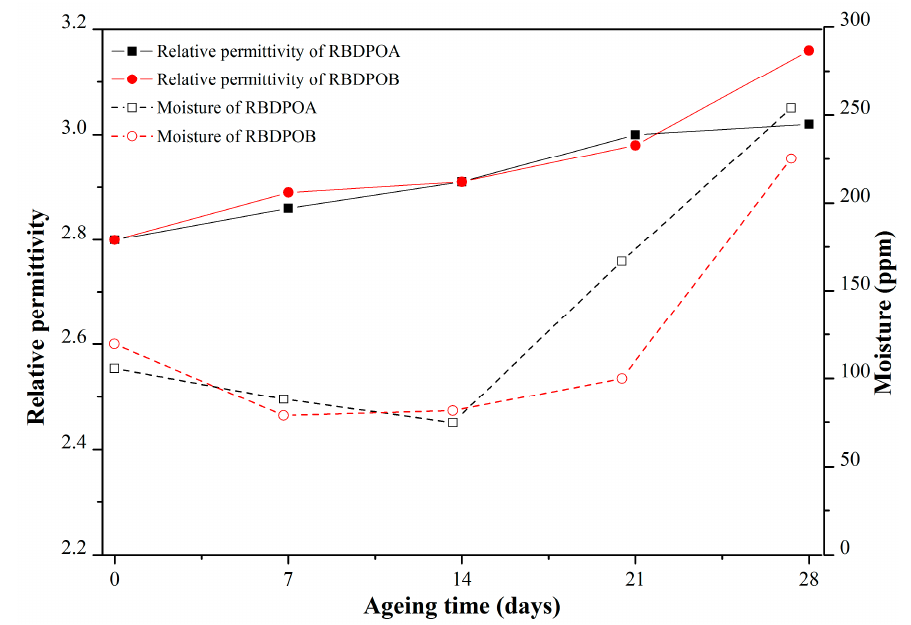
Figure 13. Relationship between relative permittivity and moisture of RBDPO aged at 170 °C under open conditions.